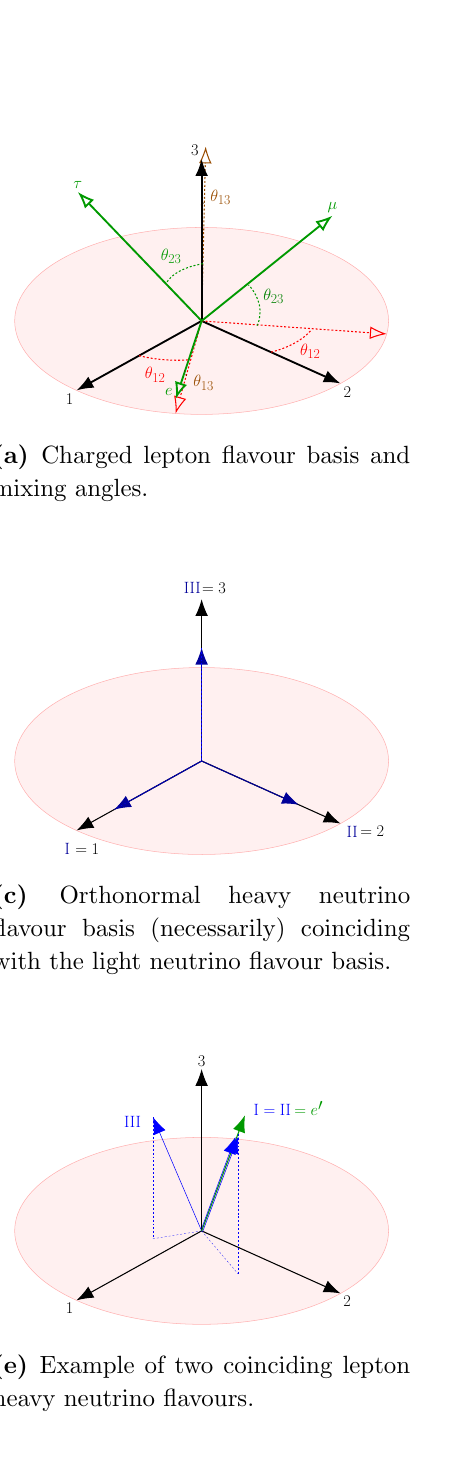
Figure 1. Examples of lepton (cid:13)avour bases with the light neutrino (cid:13)avour basis as reference basis.